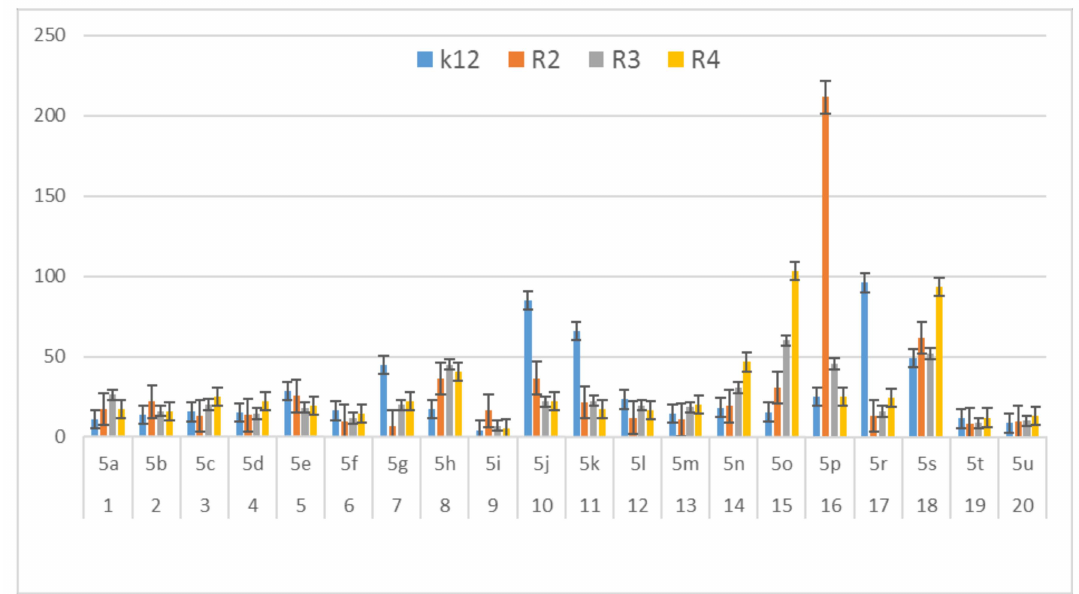
Figure 6. MBC / MIC of the α -amidoamids for the analysed strains of Escherichia coli K12 and R2, R2, and R4. The x-axis compounds 5a – 5u were used sequentially. The y-axis shows the MBC / MIC value in mg / mL − 1